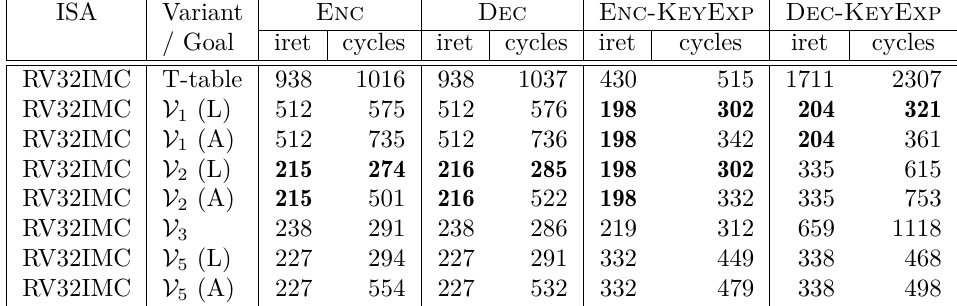
Table 3: Execution metrics for each ISE variant on the SCARV core. Note that the 64-bit V 4 is absent, since there is no 64-bit SCARV core.